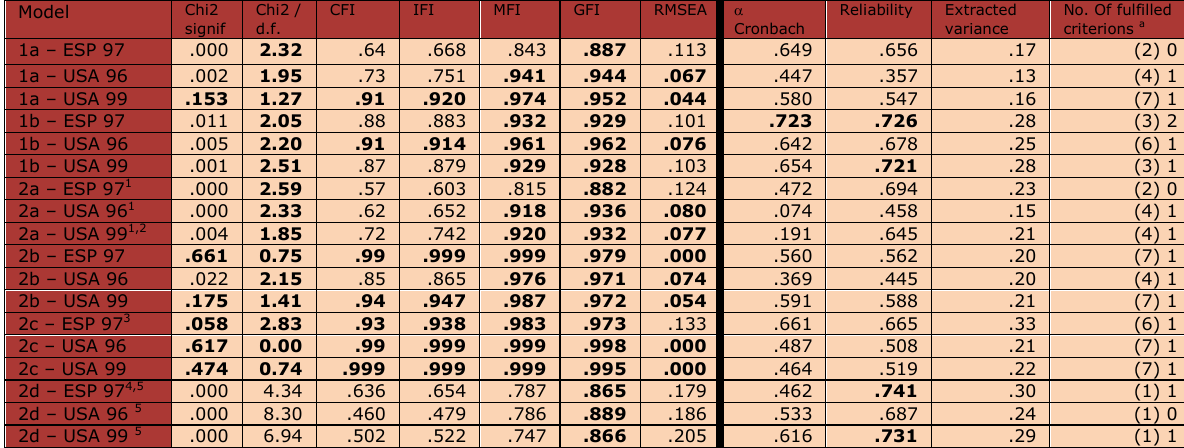
Table 10. Models adjustment indicators. a In between brackets we show how many statistics from column chi2signif to RMSEA fulfill the recommended values in table 7 for the goodness adjustment. If at least, 4 out of the 7 adjustment statistics are appropriate, we will consider that goodness adjustment exists. The other number shows how many of the four global criterions (model adjustment, Cronbach alpha, compound liability and extracted variance) follows the